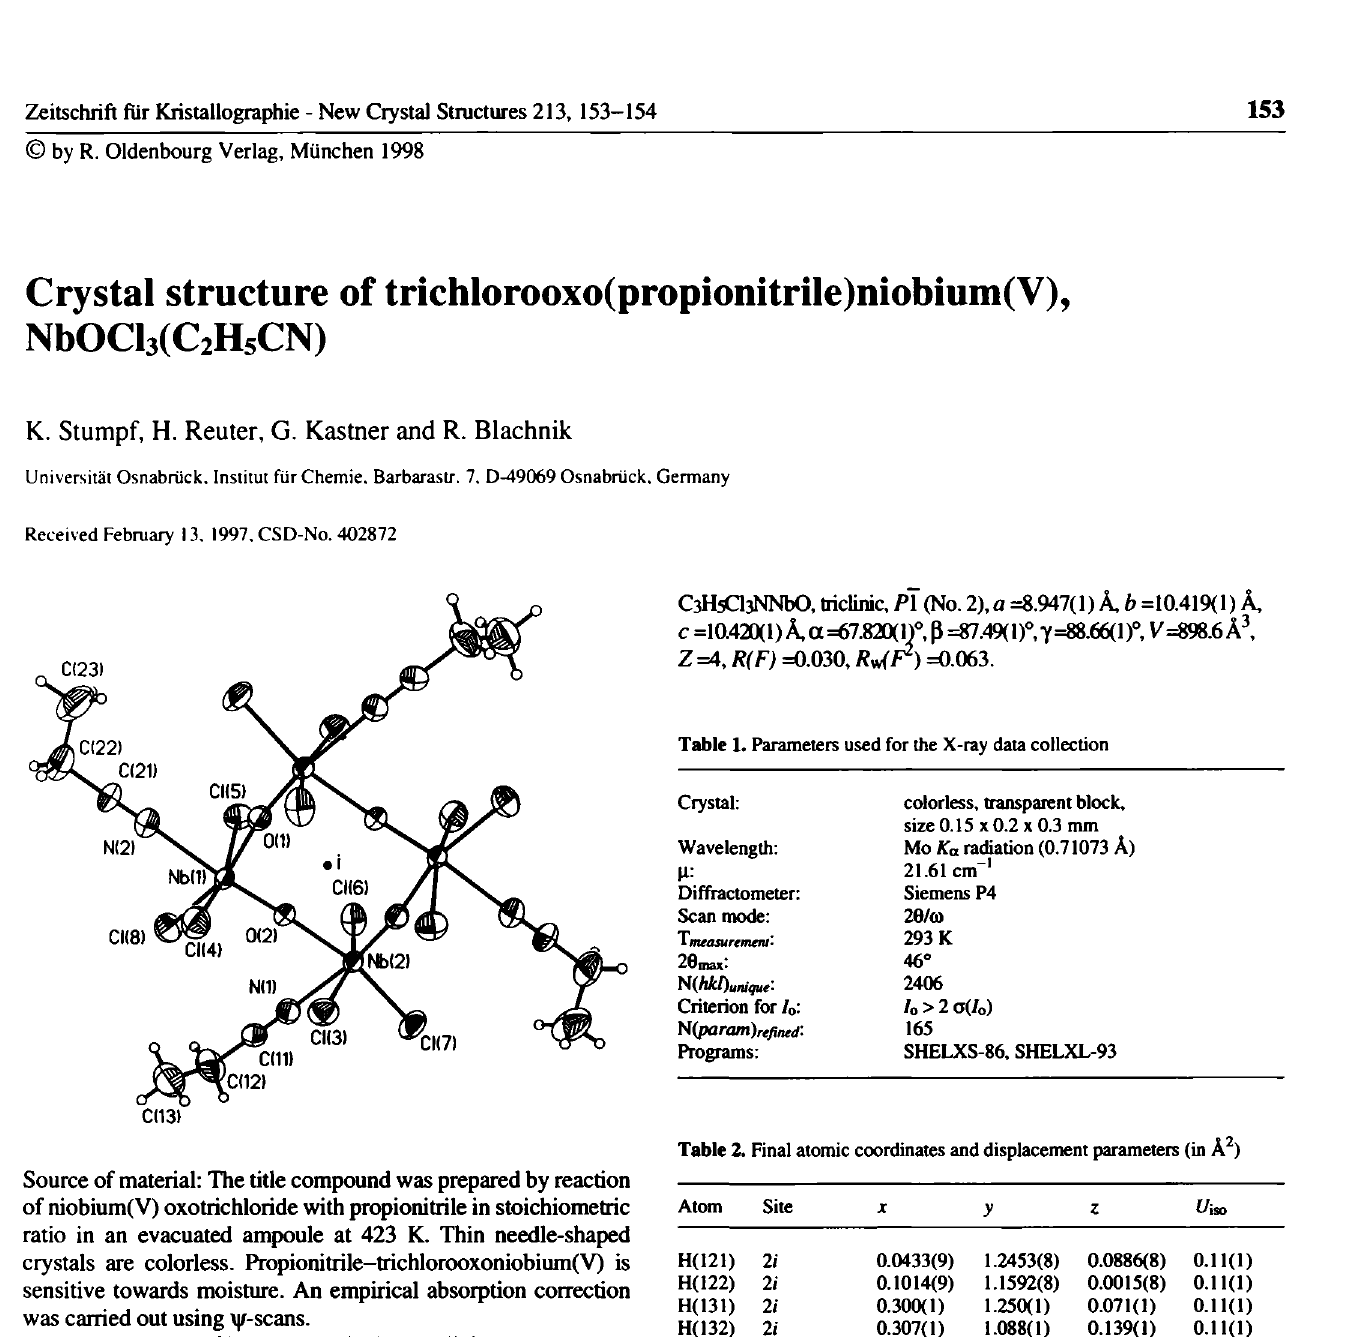
Table 3. Final atomic coordinates and displacement parameters (in Â^)